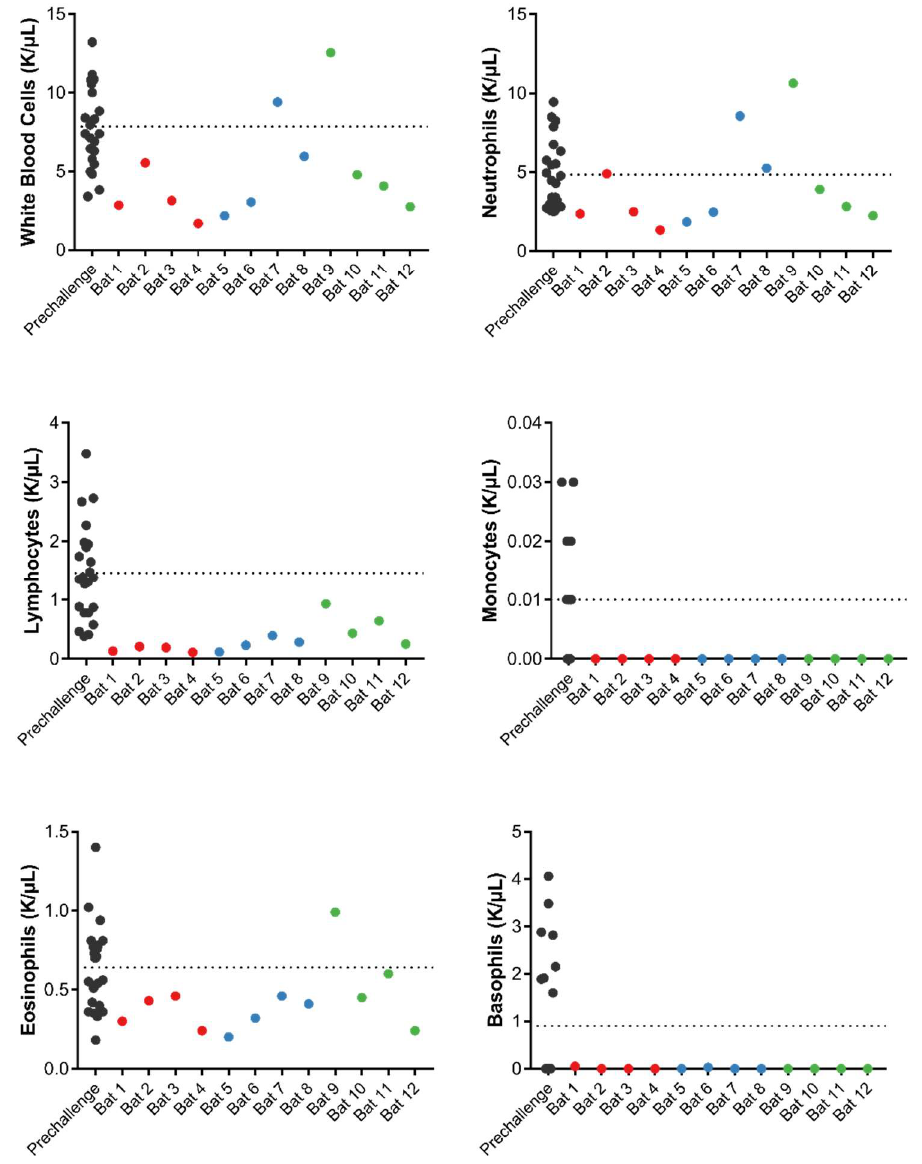
Figure 4. Hematology of Egyptian fruit bats inoculated with WIV1-CoV. Pre-challenge values (black) were obtained at D-95 ( N = 12) and D-2 ( N = 11). Post-challenge values were obtained at 3 dpi (red), 7 dpi (blue), and 28 dpi (green). All values were measured using the IDEXX ProCyte DX Analyzer. Dotted line = average of pre-challenge values.